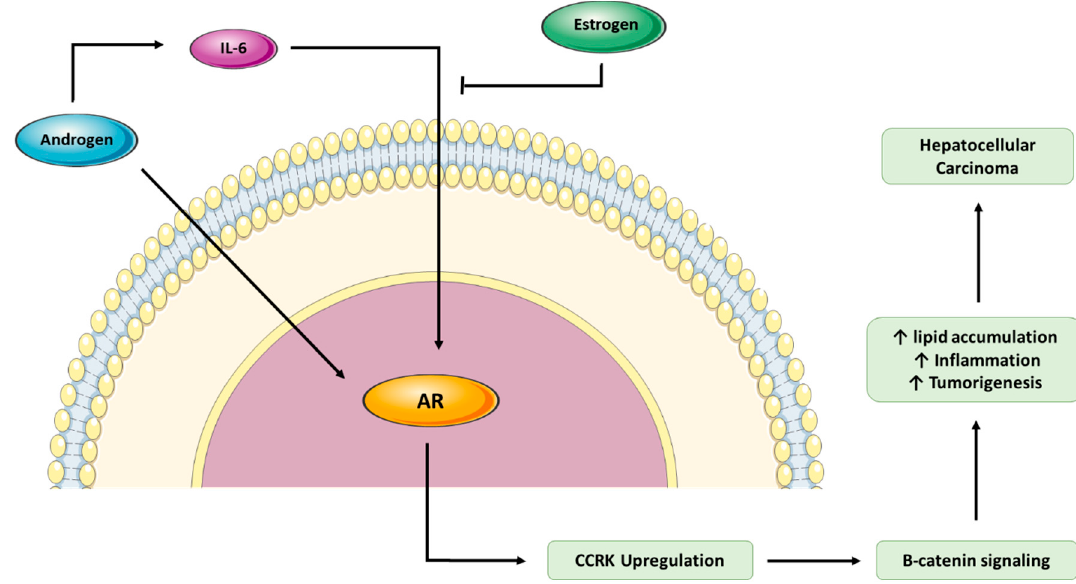
Figure 2. Role of androgens and estrogens in tumorigenesis. AR: androgen receptor, CCRK: cell cycle-related kinase.